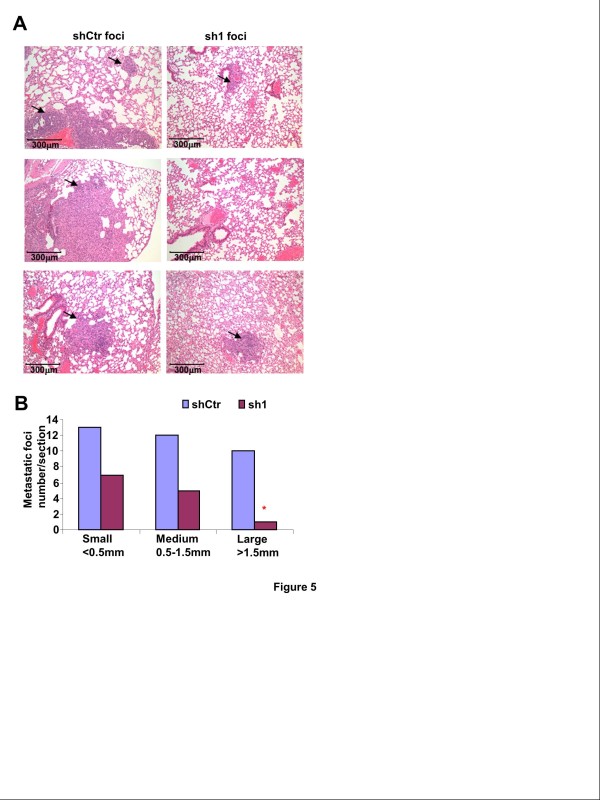
MMP-1 knockdown in BR3 cells attenuates lung metastasis. MMP-1 shRNA expressing 231-BR3 cells sh1 and control shCtr cells were injected into the tail veins of nude mice at the density of 2.5×105/100 μl PBS. Each group includes ten mice. Mice were sacrificed and lung sections were analyzed after 9 weeks. A, representative H&E staining of lung sections. Arrows indicate metastatic foci. B, for each group, total lung metastatic foci were counted. Fisher’s exact test showed a significant difference between the numbers of lung foci in the sh1 group compared to shCtr group (P < 0.05).